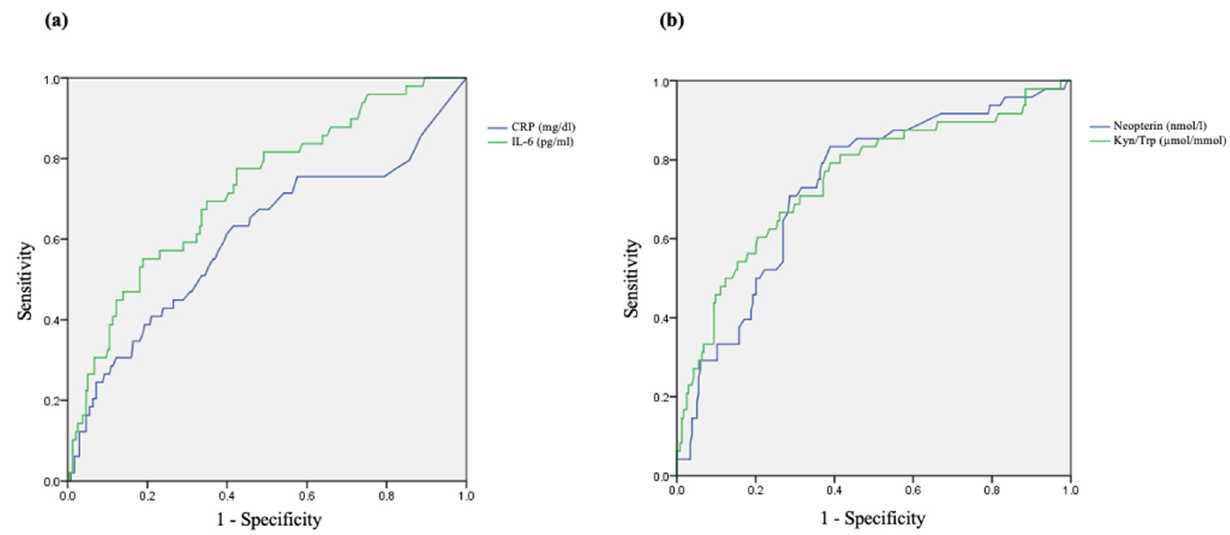
Figure 5. Receiver-operating characteristic (ROC) curves for CRP ( a ), IL-6 ( a ), neopterin ( b ), and Kyn/Trp ( b ) to predict frailty.